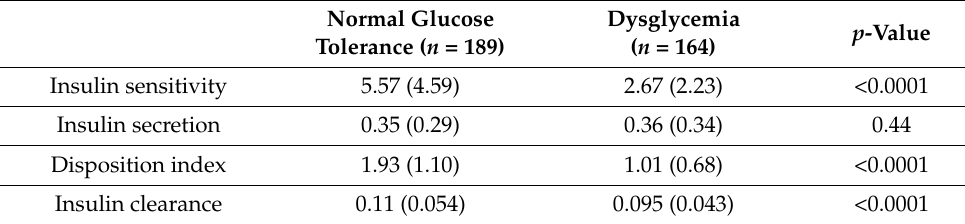
Figure 2. Insulin homeostasis traits by glycemic status. ( a ) Insulin sensitivity index (ISI); ( b ) insulin secretion; ( c ) disposition index (DI); ( d ) insulin clearance. The insulin homeostasis traits were inverse normal transformed. p -values in the upper right corner of each graph indicate overall significance by ANOVA. p -values above each graph are for pairwise comparisons by Tukey’s HSD post hoc test. Table 2. Insulin homeostasis traits in individuals with normal glucose tolerance and